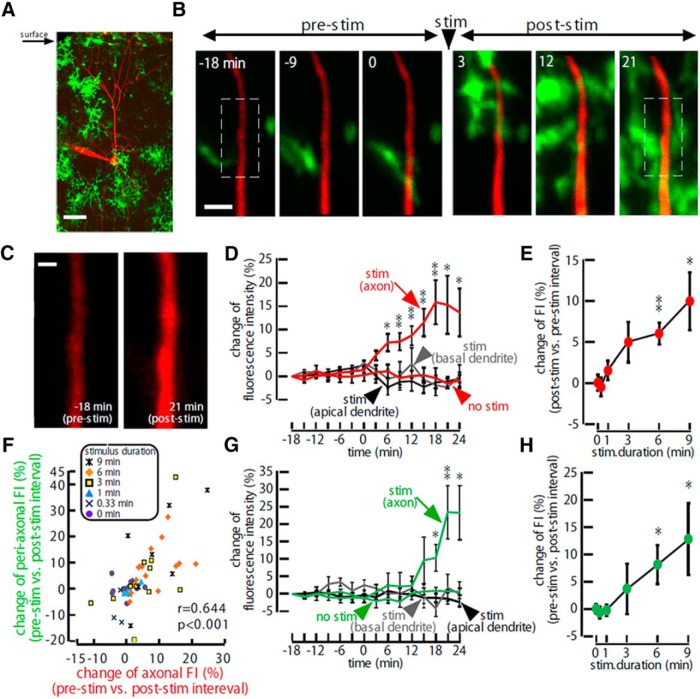
AP-induced axonal swelling and subsequent migration of microglial processes to the periaxonal area. A, A low-magnification image of a cortical slice obtained from an Iba1-GFP mice in which microglia express GFP (green). Note the largely ramified morphology suggesting a “resting state,” except for some surface microglia. A recording pipette and a pyramidal neuron, from which a recording was obtained, are loaded with Alexa Fluor 594 (red). Scale bar, 50 µm. B, Time-lapse images of a layer 2/3 somatosensory cortical neuron axon filled with Alexa Fluor 594 (red) and surrounding microglial processes (expressing eGFP, green), acquired at different times before and after a 3 min current stimulation protocol applied to the the soma of the neuron to evoke repetitive APs (at 10 Hz). Scale bar, 3 µm. C, Higher-magnification images of axonal fluorescence signals from the areas indicated by the rectangular boxes at −12 and 6 min in B. Note the increase in FI. Scale bar, 1 µm. D, G, Mean change in relative axonal and microglial FIs; before, during, and after 6 min of 10 Hz soma current stimulation applied from t = 0 (n = 16). Plots of the relative neuronal (red) FI (D) and perineuronal (green) microglial FI (G) for axons (including no stimulation controls) and dendritic compartments are superimposed (apical dendrite, black; basal dendrite, gray). E, H, Poststimulus change in relative axonal (H) and microglial (H) FIs for different durations of stimuli. F, Pooled data showing the correlation between the relative stimulus-induced changes in axonal FI and microglial FI obtained from a range of 10 Hz stimulus train durations, as indicated by each symbol.